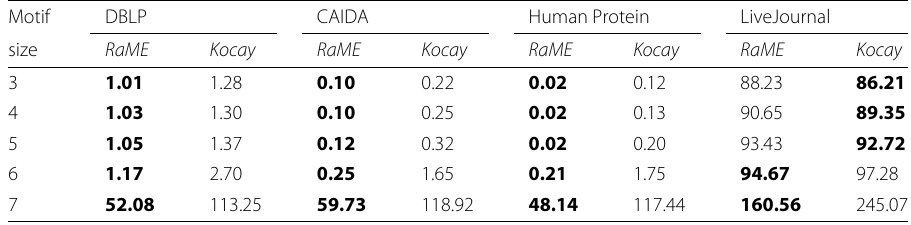
Table 2 Running times (seconds) of RaME and Kocay Lemma-based method for the computation of the induced mean of all motifs with 3-7